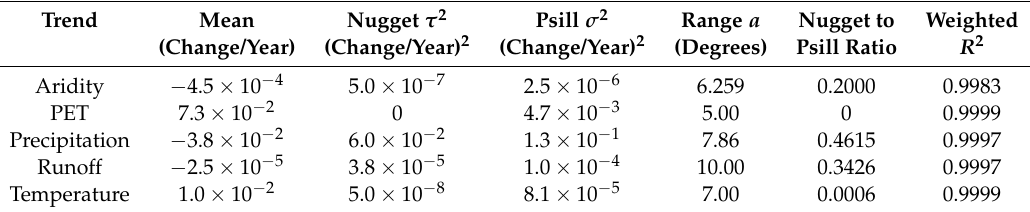
Figure 4. Empirical variogram for PET trends (blue) compared to 100 variograms for randomly re-allocated data from the same variable (grey). Table 2. Estimated parameters for each variable and results from the spatial